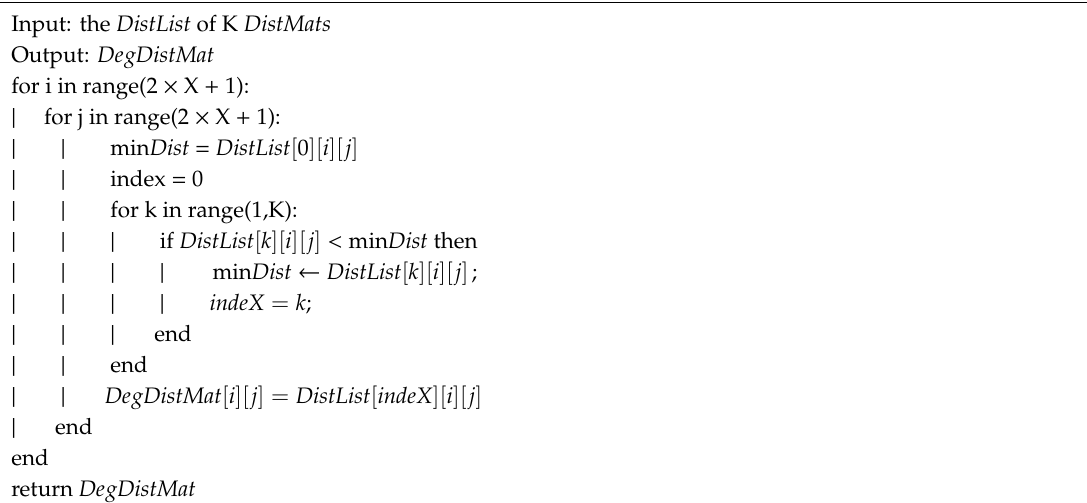
Algorithm 1 Pseudocode for obtaining DegDistMat